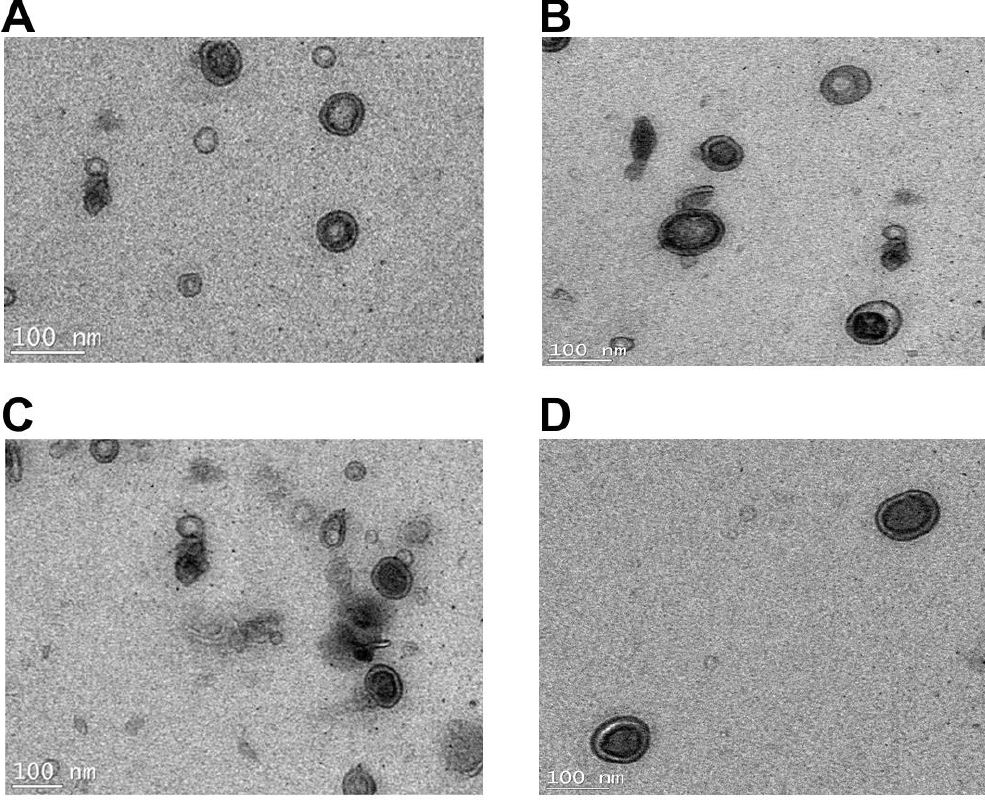
Figure 6. Transmission electron microscopy images of OMVs isolated from paired polymyxin-susceptible and -resistant strains of K. pneumoniae ATCC 700721. ( A ) OMVs from untreated K. pneumoniae ATCC 700721 (susceptible). ( B ) OMVs from polymyxin B (2 mg/L) treated K. pneumoniae ATCC 700721 (susceptible). ( C ) OMVs from untreated K. pneumoniae ATCC 700721 (resistant). ( D ) OMVs from polymyxin B (2 mg/L) treated K. pneumoniae ATCC 700721 (resistant).